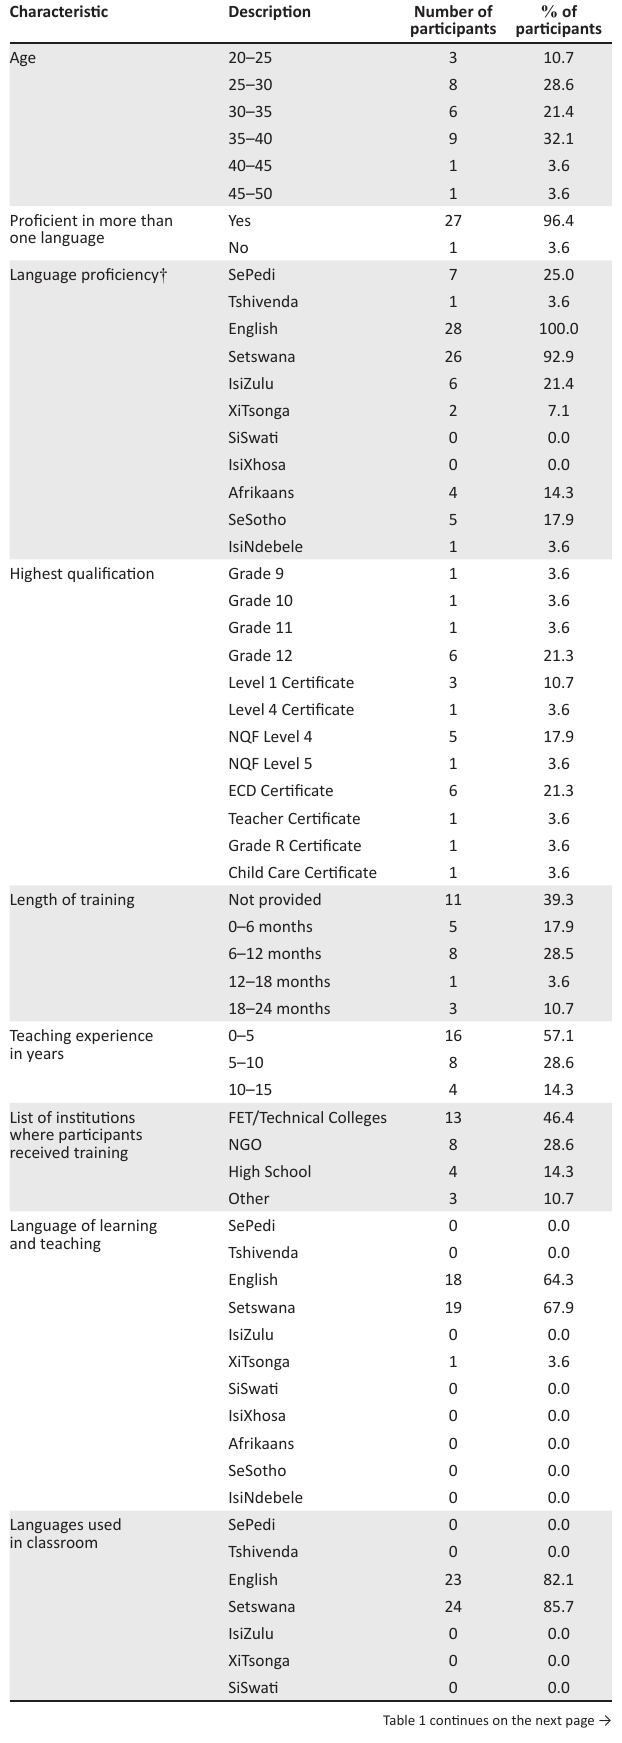
TABLE 1: Professional profile and teaching context ( n =